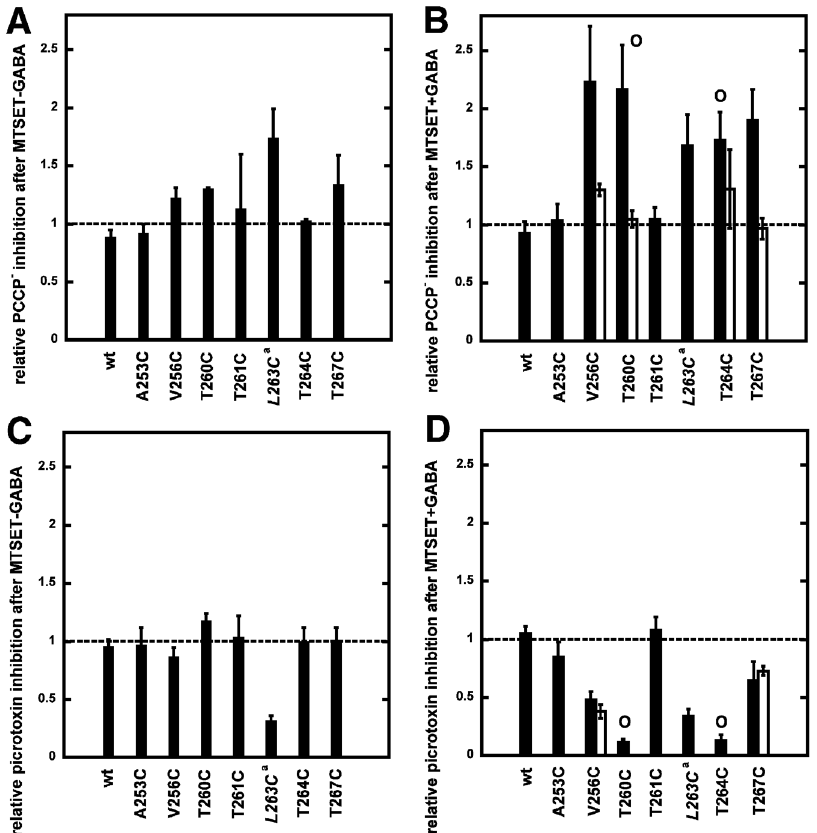
Figure 10. Effect of MTSET + on the PCCP 2 and picrotoxin inhibition of wild type and mutants GABA A receptors. Currents were elicited with GABA EC 10 . The concentration of PCCP 2 or picrotoxin was chosen such as to inhibit about 50% of the late current response in the corresponding receptor. Subsequently oocytes were treated with the cysteine-reactive reagent MTSET + and inhibition by the same concentration of PCCP 2 or picrotoxin was determined. The ratio of the inhibition after treatment divided by inhibition before treatment is shown as a bar. A, C, MTSET + was applied in the absence of GABA. B, D, MTSET + was applied in the presence of 100 m M GABA. The circle symbol on top of the bar for the T260C and T264C mutations indicates formation of an open channel after MTSET + treatment when applied in the presence of GABA. The white bars show results of experiments where the MTSET + + GABA treatment was performed in the presence of 1 mM PCCP 2 or 1 mM picrotoxin, in order to see if the covalent reaction could be prevented by the channel blockers. The asterisks sign (*) indicates that 1 mM picrotoxin was not able to suppress formation of open channels. Mean 6 SD is shown. The number of oocytes for each experimental condition is either three or six.